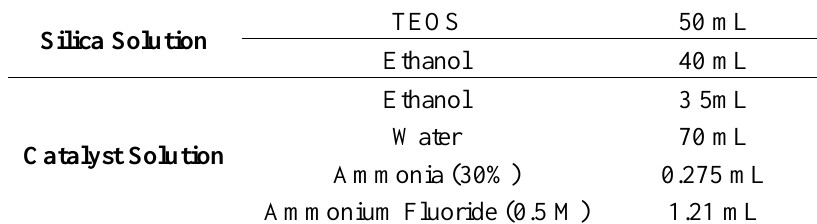
Table 2. The composition of solution and quantity used for silica